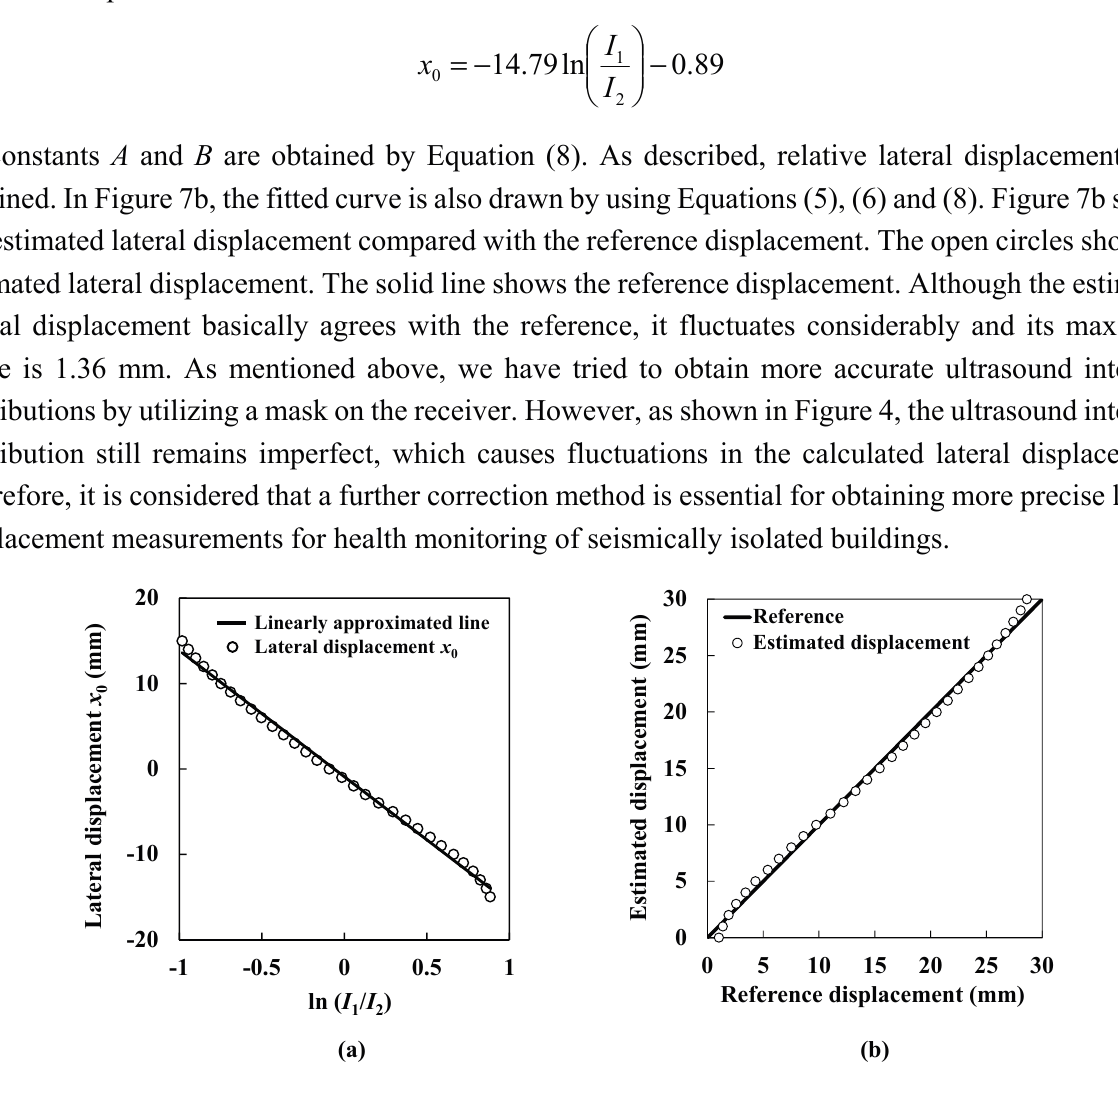
Figure 7. Estimation of lateral displacement. ( a ) Lateral displacement and the logarithm of the ratio of the ultrasound intensities obtained from the two transmitters; ( b ) Estimated lateral